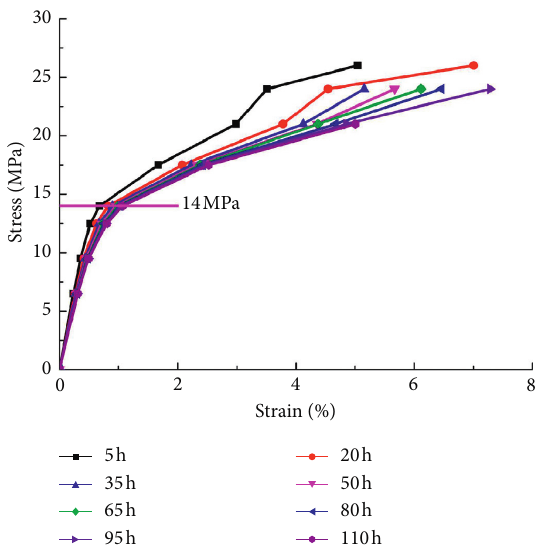
Figure 11: Isochronous stress-strain curves of salt rock